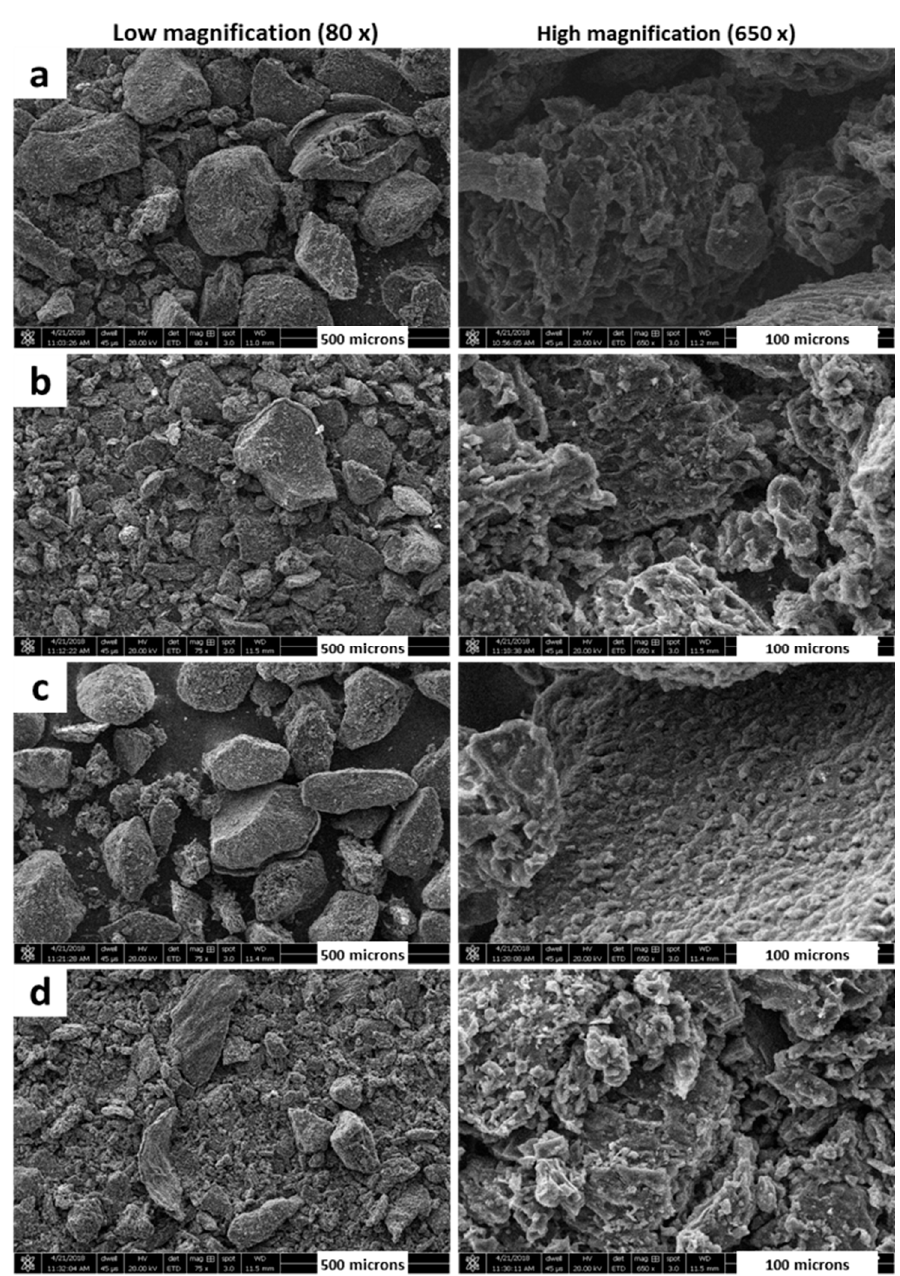
Figure 6. SEM micrographs obtained for ( a ) AC-400, ( b ) AC-500, ( c ) AC-600, and ( d ) AC-700 samples. Scale bars are 500 and 100 µ m at low (left, 80 × ) and high (right, 650 × ) magnifications,